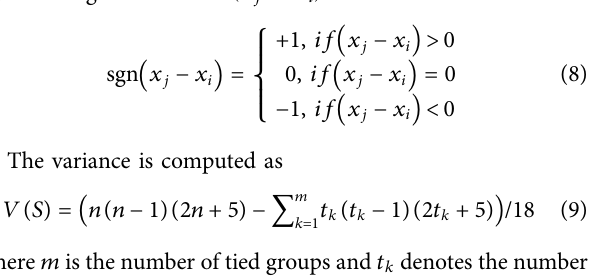
Frontiers in Environmental Science |